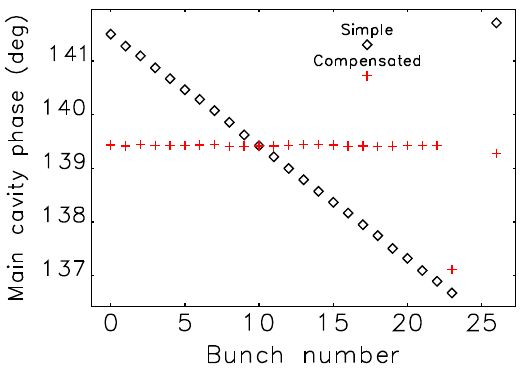
FIG. 16. Charge distribution over 1000 turns from 30-slice analysis for guard bunch 26 of a fill with twelve 2-bunch gaps.